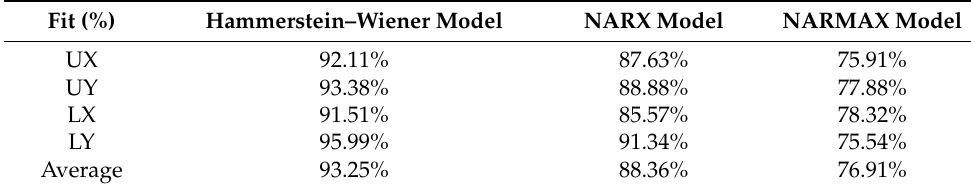
Figure 21. Comparison of the proposed Hammerstein-Wiener model, NARX model, and NARMAX model. Table 1. Fit values between validation data and responses of Hammerstein–Wiener model, NARX model, and NARMAX